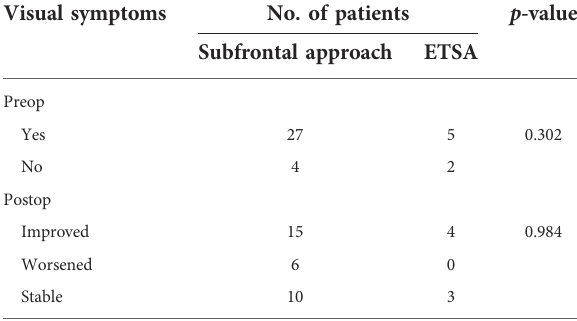
TABLE 4 Results of visual acuity in relation to tumor